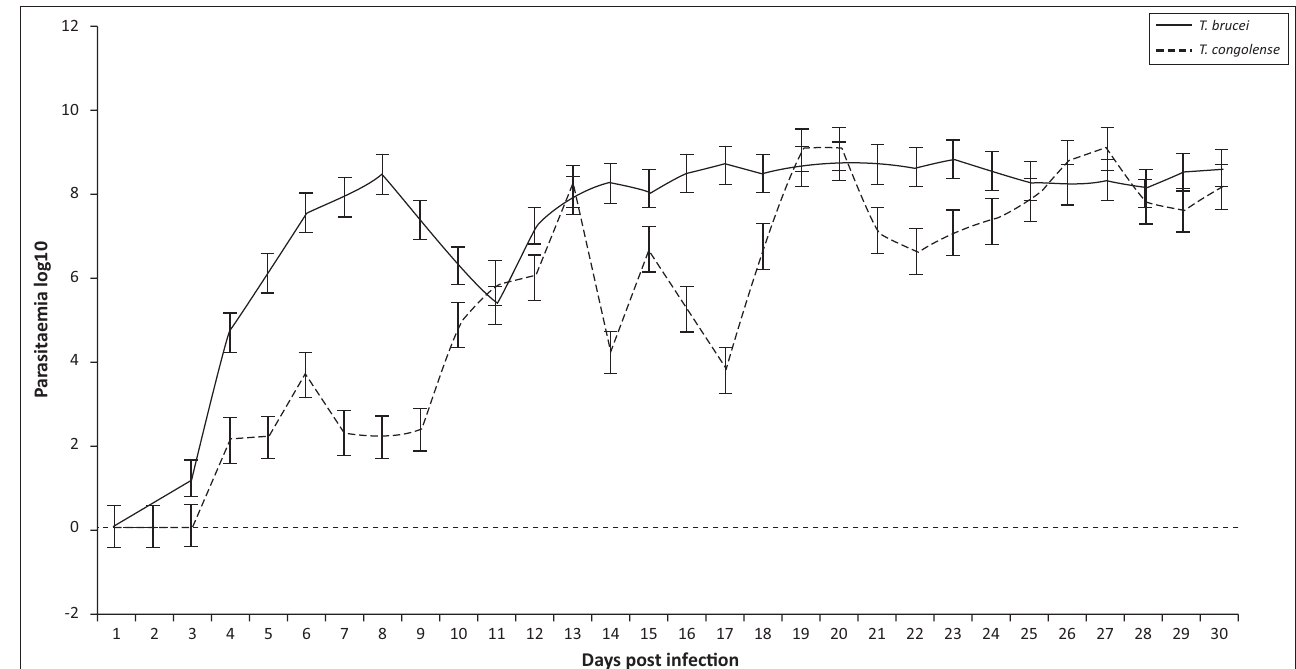
FIGURE 1-A1: Comparison of mean ± standard error parasitaemia profiles in mice infected with Trypanosoma brucei and Trypanosoma congolense